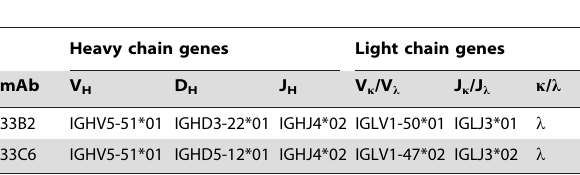
Table 2. Genetic characteristics of V3-specific